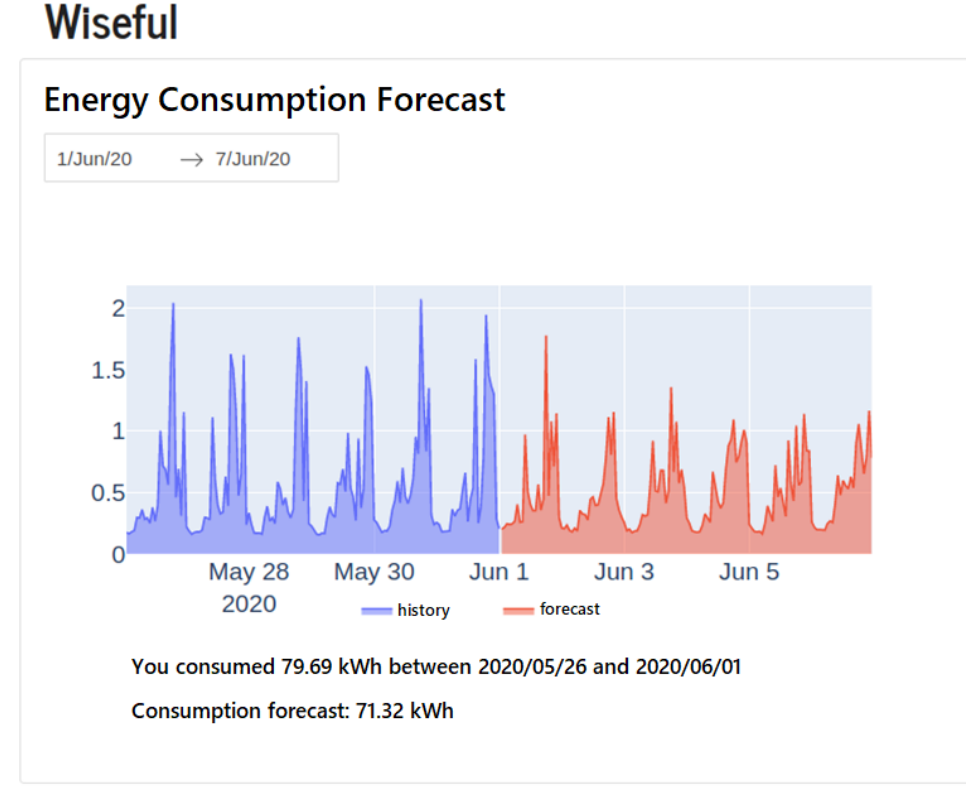
Figure 10. Website for visualizing consumption